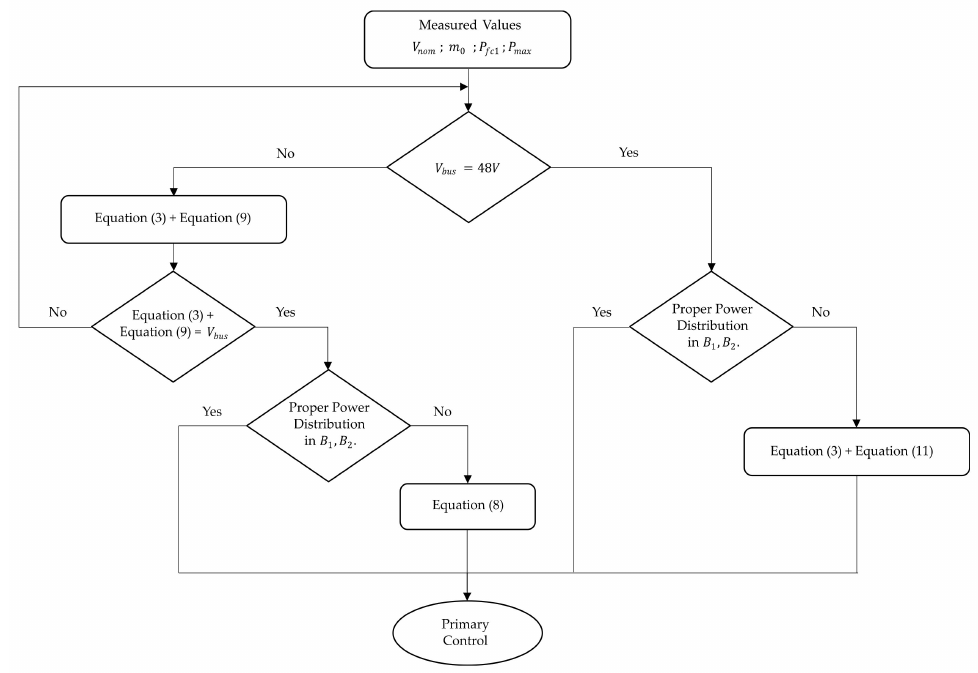
Figure 10. Flow chart for Distributed Secondary Controller for Efficient Battery Management.